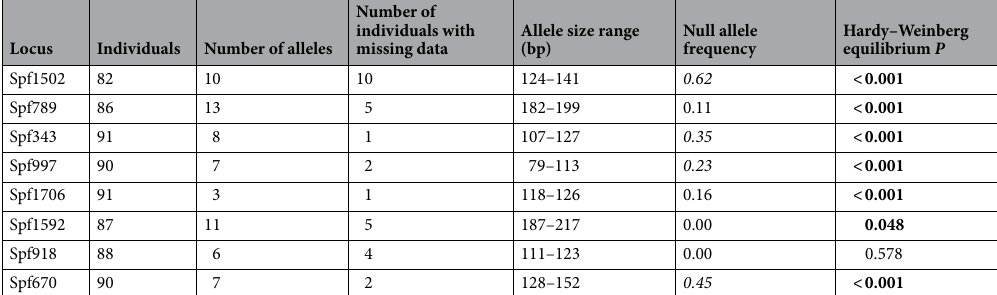
Table 2. Locus and allele information for each of the eight microsatellites, and HWE results. Those loci with high null allele frequencies are in italics. Loci which significantly deviate from HWE are in bold and were calculated using a Monte Carlo Exact Test.